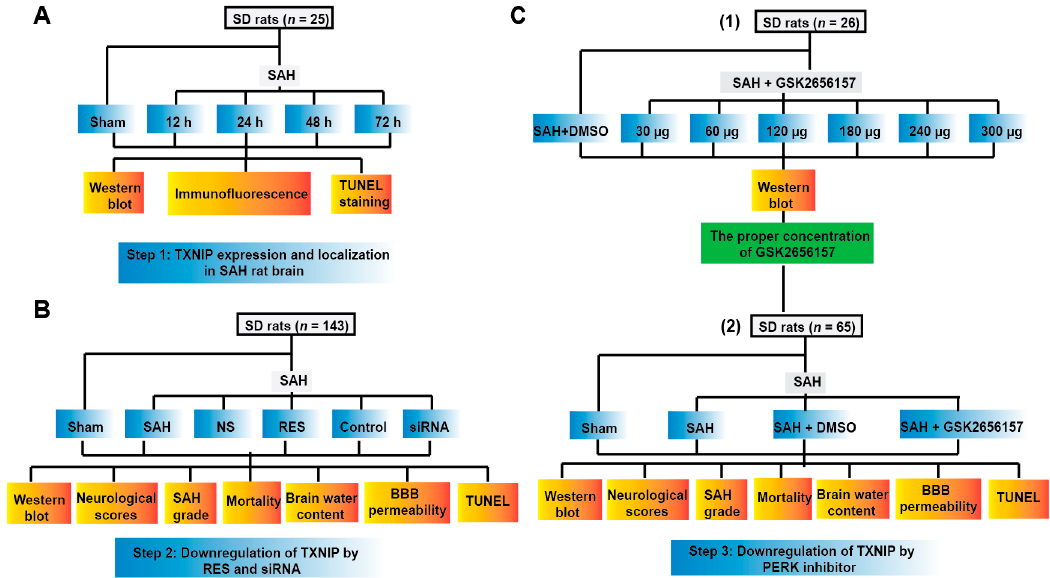
Figure 1. Experimental design ( A – C ). SD rats, Sprague–Dawley rats; SAH, subarachnoid haemorrhage; NS, SAH + normal saline; RES, SAH + resveratrol; Control, SAH + control siRNA; siRNA, small interfering RNA; BBB, blood-brain barrier; DMSO, dimethyl sulfoxide; TXNIP, thioredoxin-interacting protein; PERK, protein kinase RNA-like endoplasmic reticulum (ER) kinase.